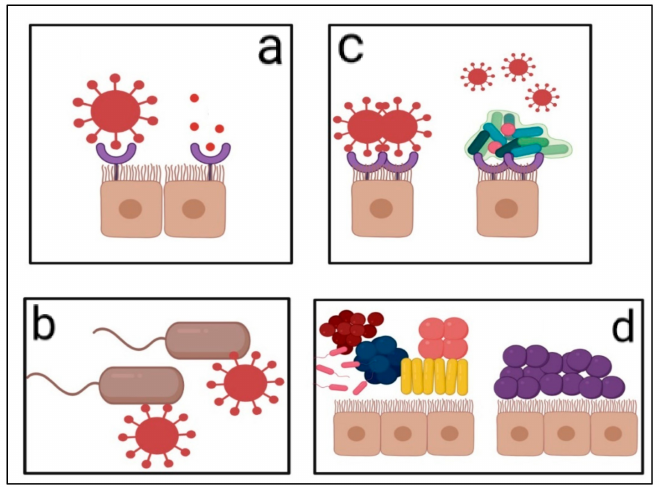
Figure 4. Probiotic-based interference with epithelial virus receptors. ( a ) Some probiotics produce proteins that mimic viral binding proteins, therefore saturating epithelial receptors [76]. The red circles represent probiotic-derived proteins that mimic proteinaceous spikes of infecting virions as seen on the left-hand side of ( a ). ( b ) Other probiotics can occupy viral spike proteins upon binding to an infecting virus. This results in the inability of the virus to detect receptor proteins of host cells [64]. ( c ) Probiotic biofilm formation, as seen on the right-hand side, covers the receptor proteins of epithelial cells, rendering invading viruses incapable of attaching to host cell receptor proteins. This results in the inability of the virus to infect a susceptible host as seen on the left-hand side of Figure ( c ). Where the mechanism depicted by ( b ) represents probiotic hindering of viral spike proteins, ( c ) represents the incapacitation of host cell receptor proteins to be detected by viruses due to the fact that these proteins are covered by probiotic biofilms [6,77]. ( d ) In the Figure to the left-hand side of ( d ), a vast array of non-synonymous bacteria colonises the epithelial cells of a host. By ensuring that these cells are rather solely colonised by gram-positive bacteria, as seen on the